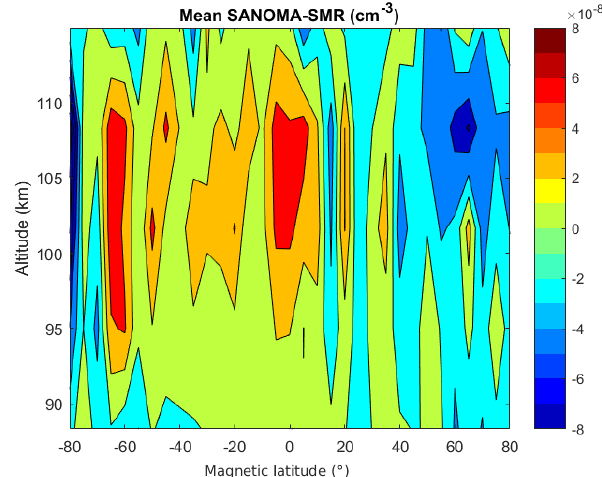
Figure 10. Mean of the differences (in cm − 3 ) between the time series of SANOMA-simulated and SMR-measured